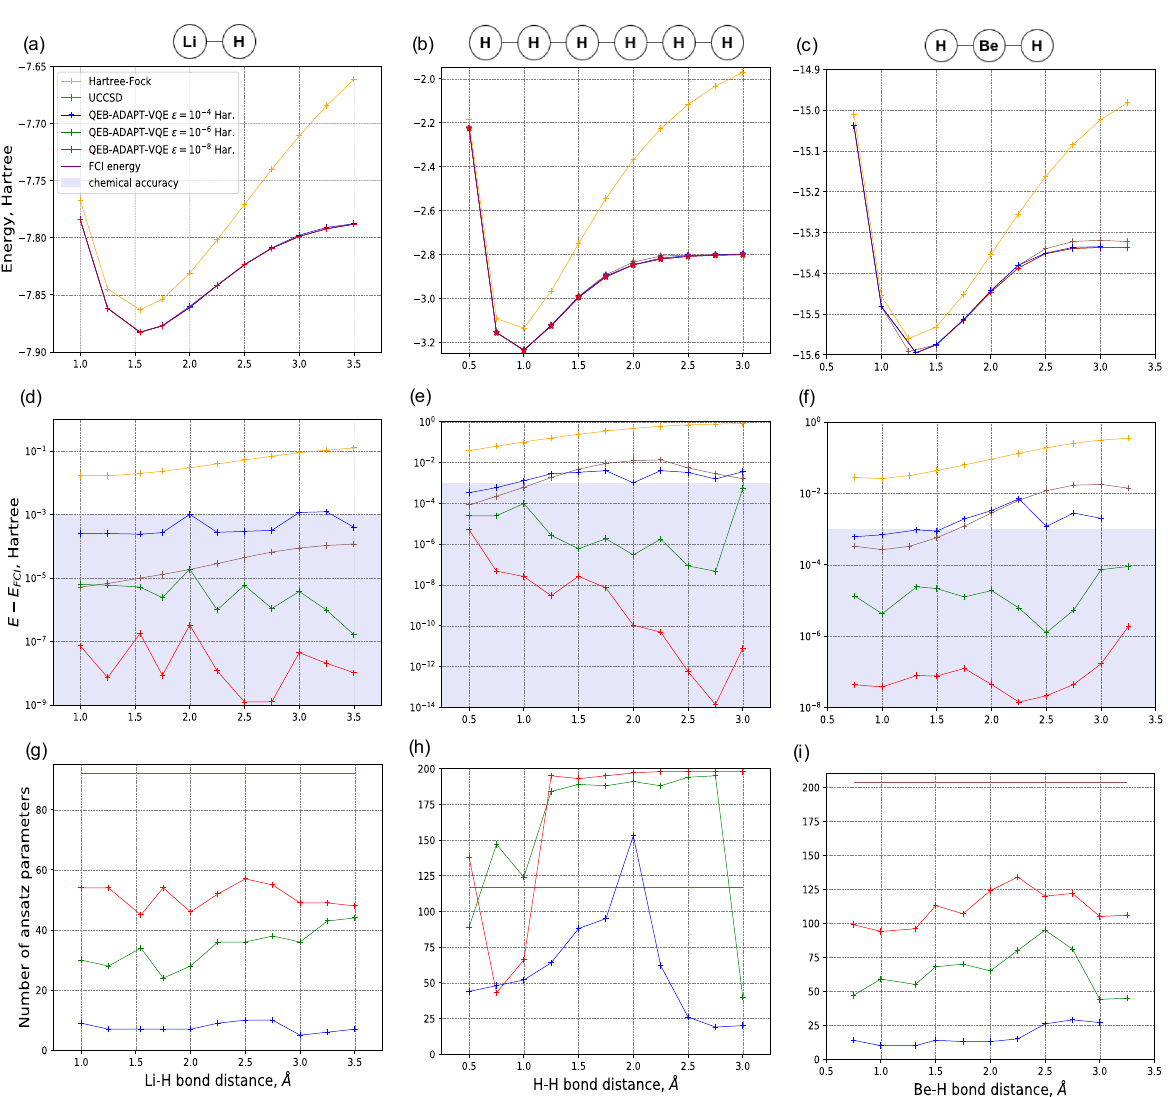
Fig. 5 Energy-dissociation curves for LiH, H 6 , and BeH 2 molecules in the STO-3G orbital basis set. a – c Absolute energy as a function of bond distance. d – f Energy error with respect to the exact FCI energy as a function of bond distance. g – i Number of ansatz variational parameters required to reach the energy accuracies in ( d – f ). The QEB-ADAPT-VQE is performed for n = 10 and step 5 implemented. The number of variational parameters for the UCCSD is 92, 117, and 204 for LiH, H 6 , and BeH 2 , respectively. The number of variational parameters is also equivalent to the number of ansatz elements of each